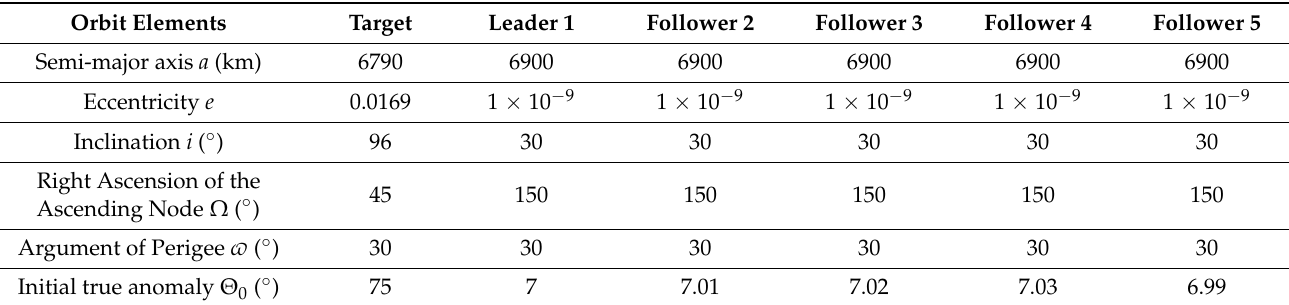
Table 1. Orbit elements of the target and spacecraft.